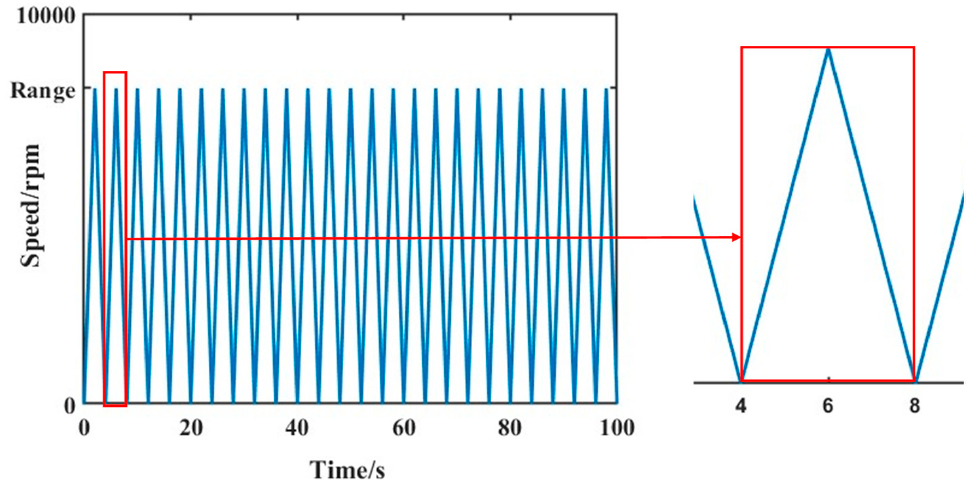
Figure 28. Speed-changing operating condition.